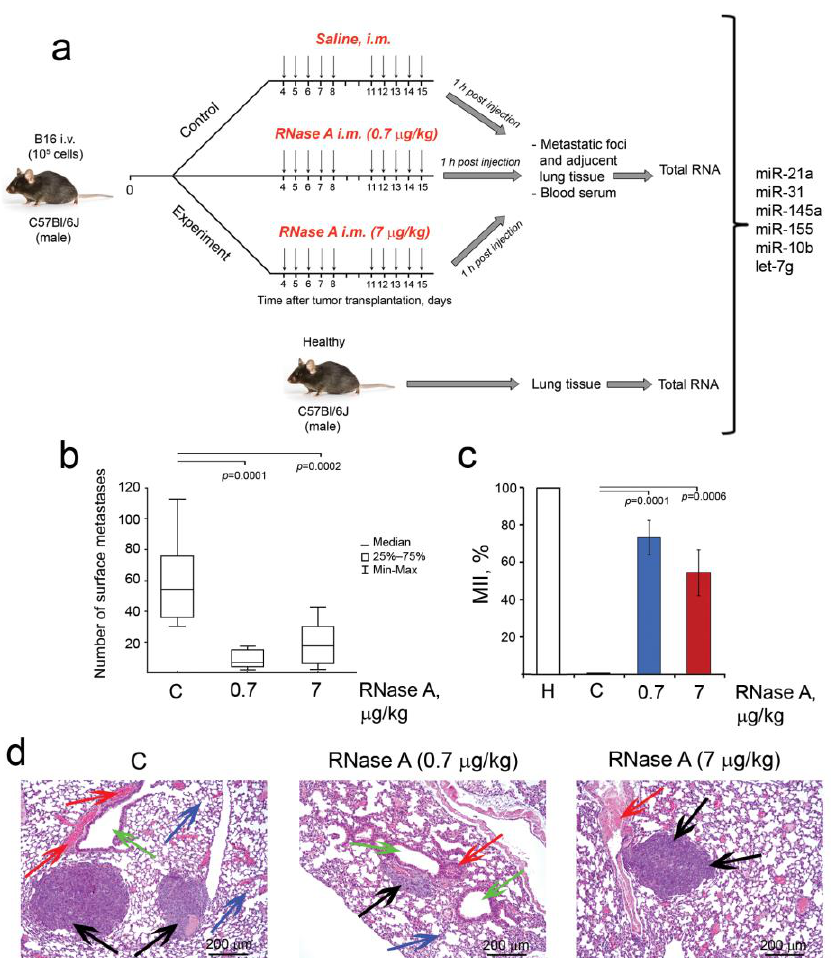
Figure 5. The influence of RNase A on the metastasis development in B16 melanoma-bearing mice. ( a ) Design of the experiment. B16 cells (10 5 cells, 0.2 mL) were i.v. implanted into C57Bl/6 mice. Starting on day 5 after B16 implantation, animals received saline buffer or RNase A (0.7 and 7 µg/kg) i.m. daily, except weekends. On day 15, mice were sacrificed 1 h after the last injection, and the lungs were collected for calculation of surface and internal metastases. Metastatic foci and adjacent lung tissue, lung tissues from healthy C57Bl/6 mice and blood samples were collected; total RNA was isolated and used for miRNA analysis. ( b ) Number of surface lung metastases. ( c ) Metastasis inhibition index (MII). Data were statistically analyzed using one-way ANOVA with a post hoc Tukey test and are presented as median ( b ) and as mean ± SE ( c ). Statistical significance: p ≤ 0.05. ( d ) Representative histological images of the lungs of B16 melanoma-bearing mice treated with RNase A. Metastatic foci, adjacent lung tissue, blood vessels and bronchi are indicated by black, blue, red and green arrows, respectively. Hematoxylin and eosin staining, original magnification ×100. C – mice with B16 treated with saline buffer.